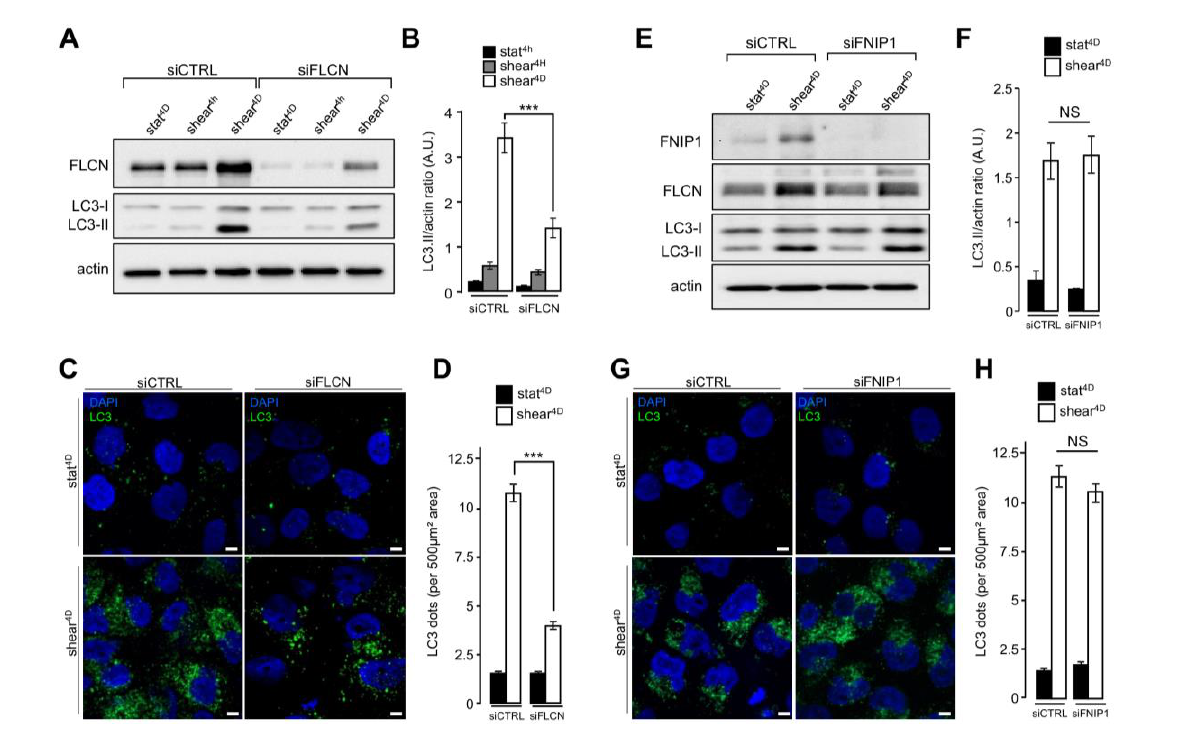
FIGURE 3: FLCN, but not FNIP1, is required for shear stress-induced autophagy. (A-D) HK2 cells were transfected either with siRNA targe- ting FLCN (siFLCN) or control siRNA (siCTRL) 72 h later they were subjected to fluid flow (shear) for the indicated times or not (static). (A) Levels of FLCN, LC3I and LC3II were analyzed by western blot and LC3 II/actin ratio was quantified (B) . (C) Cells were fixed, labeled with DAPI, immunostained for LC3 and then analyzed by fluorescence microscopy. (D) LC3 dots were quantified from experiments shown in (C). (E-H) HK2 cells were transfected either with siRNA targeting FNIP1 (siFNIP1) or control siRNA (siCTRL). 72 h later they were subjected to fluid flow for 4 days (shear 4D) or not (static 4D). (E) Levels of FNIP1, FLCN, LC3I and LC3II were analyzed by western blot and LC3 II/actin ratio was quantified (F) . (G) Cells were fixed, labeled with DAPI, immunostained for LC3 and then analyzed by fluorescence microscopy. (H) LC3 dots were quantified from experiments shown in (G) . Scale bars in (C) and (G) =